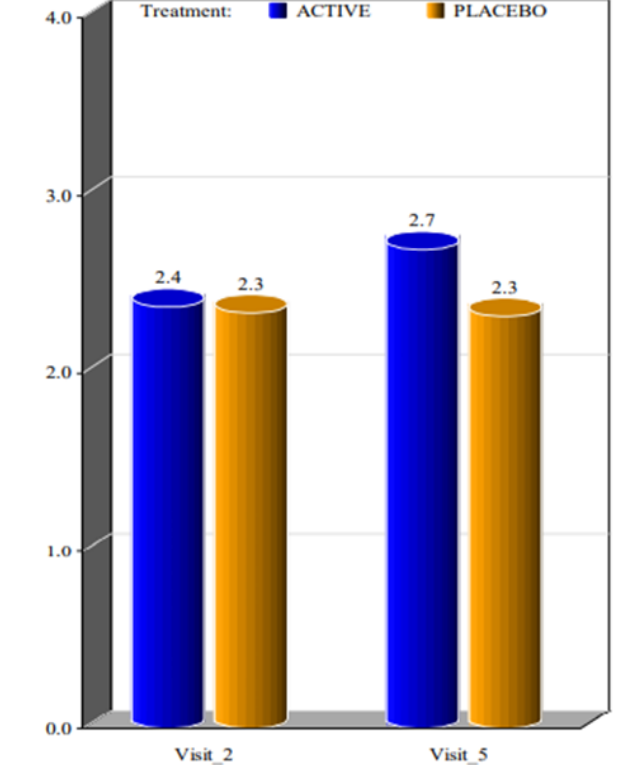
Figure 3. Mean value of SF36 considering the 36 questions at the first visit and at visit 4 weeks after the beginning of the treatment. (Visit 2 corresponds to the visit performed on day 0, as Visit 1 corresponds to the day of laboratory tests).